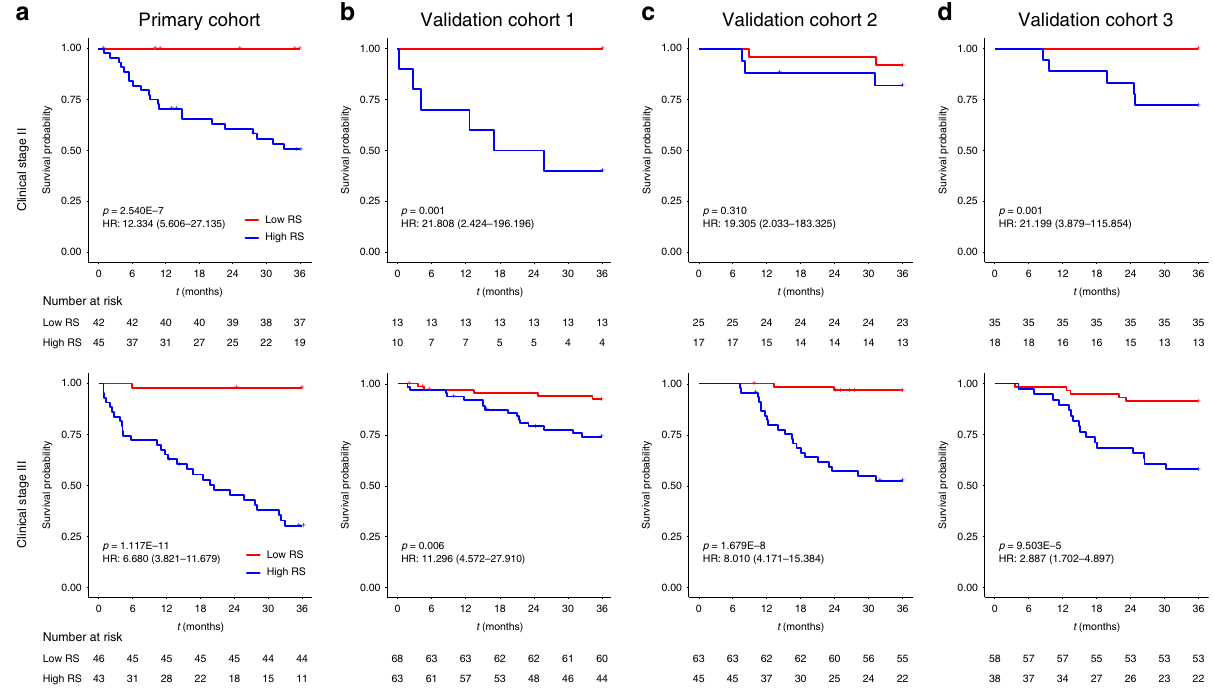
Fig. 2 K – M DMFS curves according to the RS among LARC patient subgroups. a The primary cohort (upper: stage II, n = 87; lower: stage III, n = 89). b Validation cohort 1 (upper: stage II, n = 23; lower: stage III, n = 131). c Validation cohort 2 (upper: stage II, n = 42; lower: stage III, n = 108). d Validation cohort 3 (upper: stage II, n = 53; lower: stage III, n = 96). p values were calculated using two-sided log-rank test. RS radiomic signature; HR hazard ratio; DMFS distant metastasis-free survival; LARC locally advanced rectal cancer. Source data are provided as a Source Data fi le.